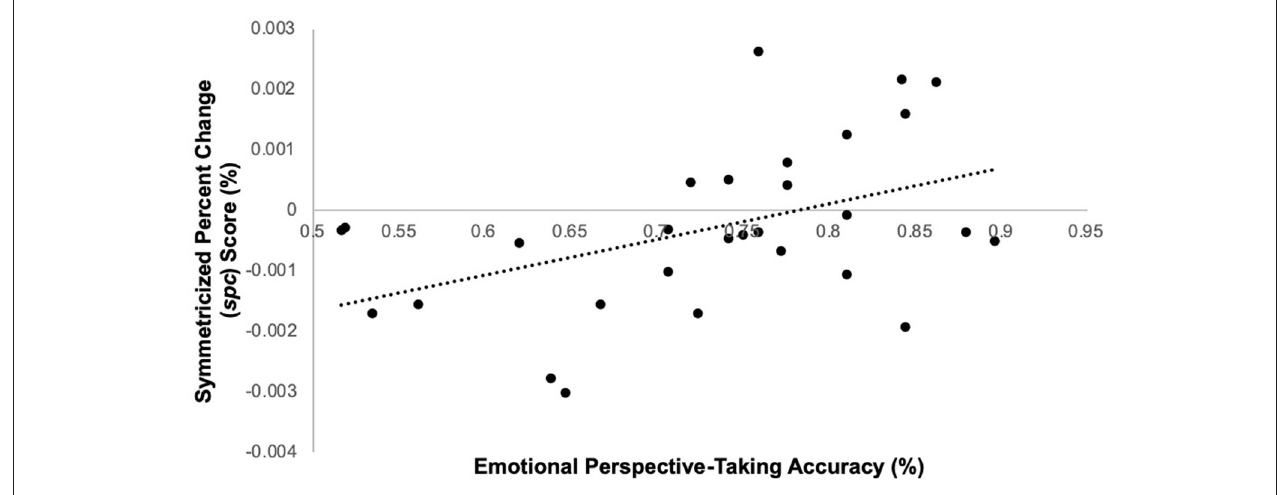
FIGURE 2 | Emotion perspective-taking performance predicts symmetrized percent change score in right TPJ in schizophrenia participants only.